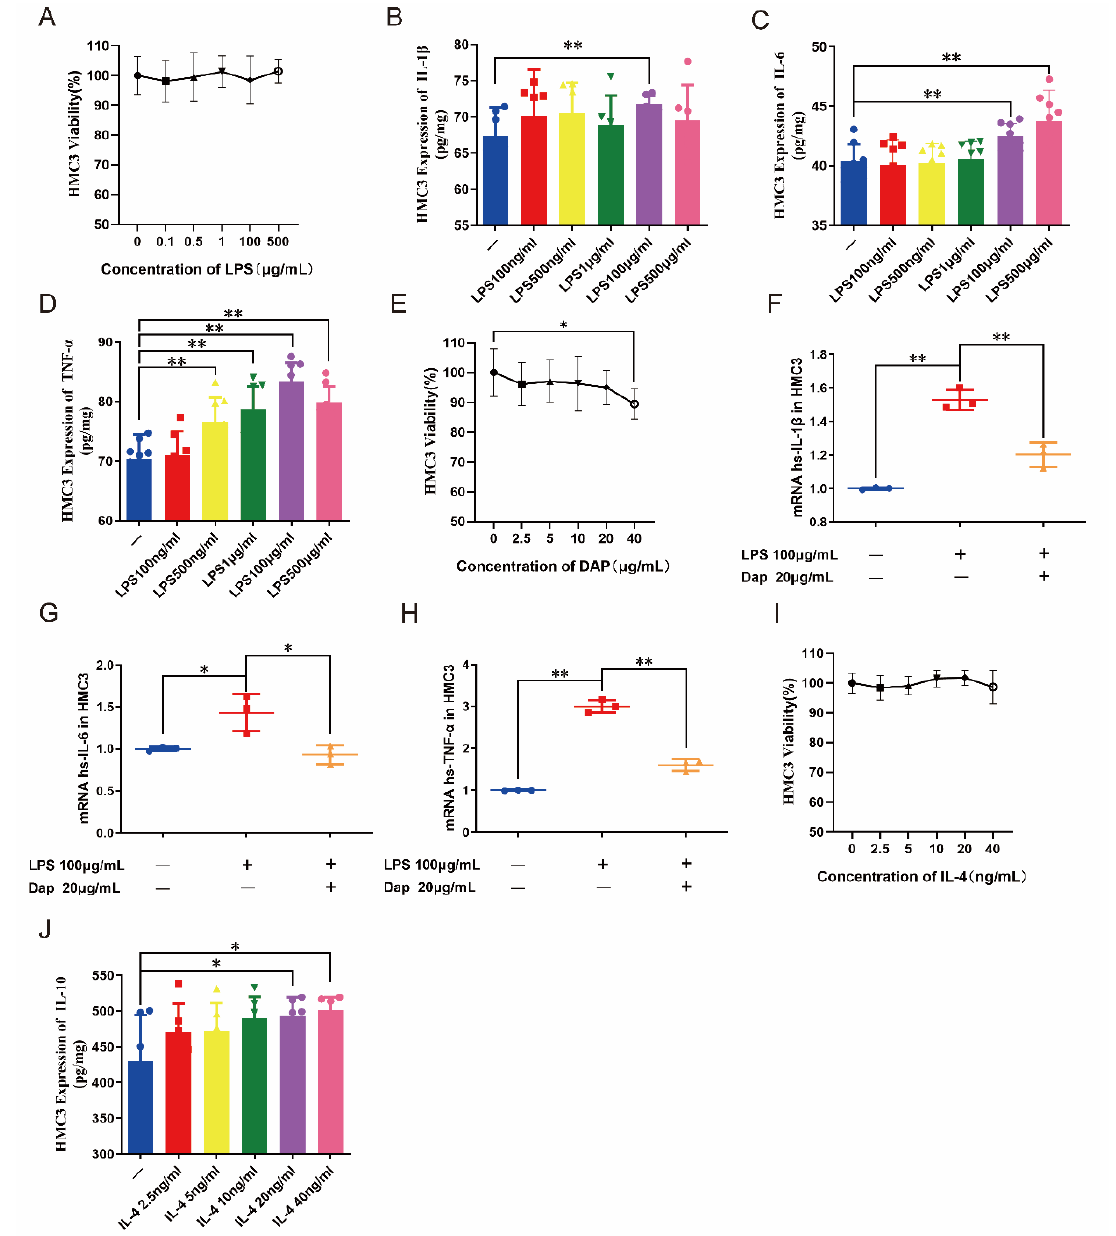
Figure 5. Effect of daphnetin on HMC3 cells. ( A ) Effect of different concentrations of LPS on the cell viability of HMC3 ( n = 6). ( B – D ) Effect of different concentrations of LPS on the expression of inflammatory factors in HMC3 cells ( n = 6). ( E ) Effect of different concentrations of daphnetin on the cell viability of HMC3 cells ( n = 6). ( F – H ) Effect of daphnetin on inflammatory factors in LPS − induced HMC3 cells ( n = 6). ( I ) Effect of different concentrations of IL − 4 on the cell viability of HMC3 ( n = 6). ( J ) Effect of different concentrations of IL-4 on the expression of inflammatory factors in HMC3 cells ( n = 6). * p < 0.05, ** p < 0.01. Blue circles, red squares, green triangles, yellow triangles, purple and pink circles refer to the individual data of each group, respectively.